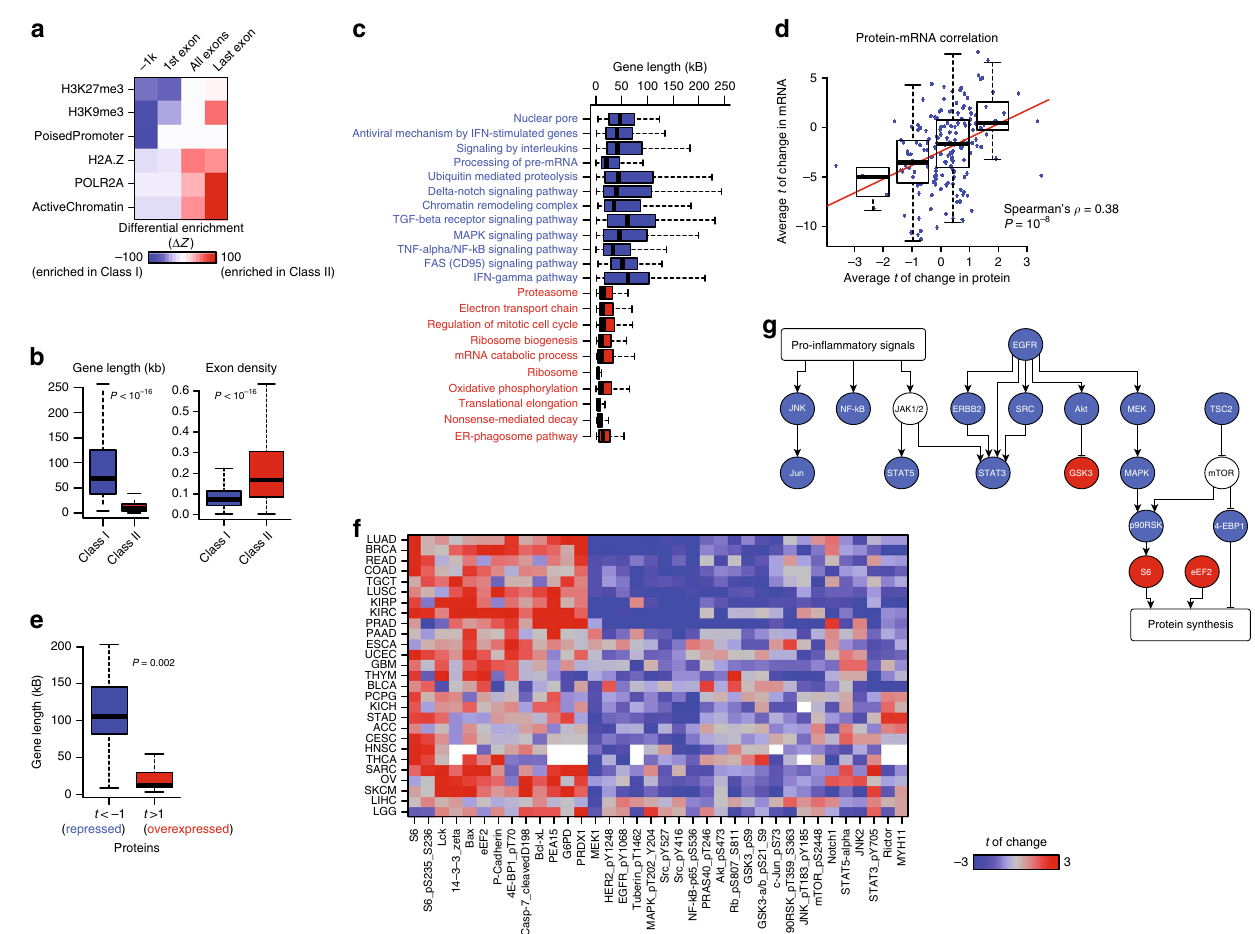
Fig. 2 TE deff impairs the expression of stimulus-responsive genes and pathways. a Differential enrichment of Class I and II genes for the gene features de fi ned in the Roadmap Epigenomics datasets. b Genomic lengths (left) and exon density (ratio of full mRNA/genomic length) pro fi les (right) of Class I and II genes ( P : t-test). c Genomic length distributions of constituent genes in the Class I- and Class II-enriched ( P < 0.0001, hypergeometric test) pathways (colored blue and red, respectively). d Scatter plot of average t-statistic of change in mRNA ( y -axis) and corresponding total protein ( x -axis) in TE deff vs. TE prof samples across cancers. e Gene lengths of proteins that are repressed (average t-statistic < − 1) or overexpressed (t-statistic >1) in TE deff cancers. e A heatmap of some of the most consistent protein-level changes in TE deff vs. TE prof samples in the indicated cancer types ( P : t -test). f A diagram of representative pathways from commonly repressed and overexpressed phospho- and total proteins in F (blue: repressed, red: overexpressed). Compare the pathways with the mRNA-level pro fi le in c . Boxplots:: middle line: median, boxed areas extend from the fi rst to third quartile; whiskers show 1.5x inter- quartile range from the fi rst (bottom) or third (top)